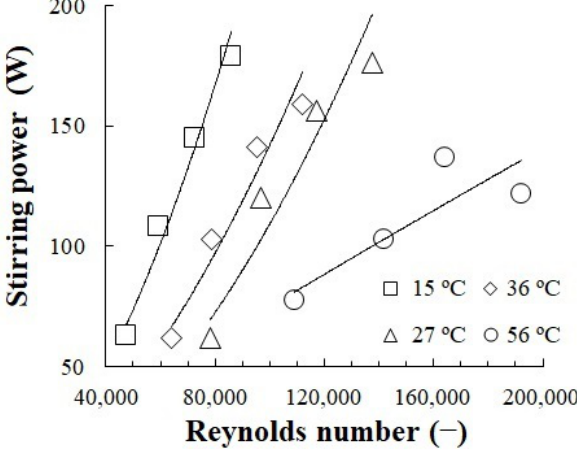
Figure 12. The dependence of the mixing power on the Reynolds number at h = 0.3 (m), one partition, H L / D = 1.2, d s = 0.064 (m), D = 0.28 (m) at n = 600–2400 (rpm).